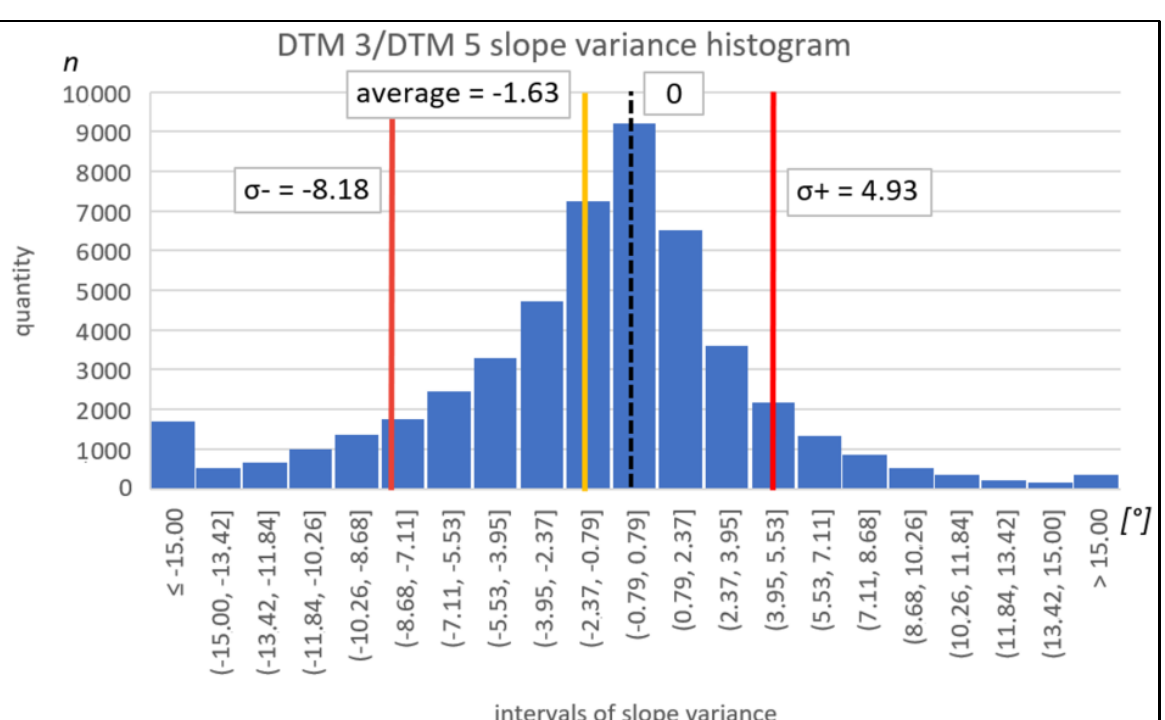
Figure 2. Histogram of standard deviations of the comparison between DTM 4 and DTM 5 for slopes at 50,000 points.